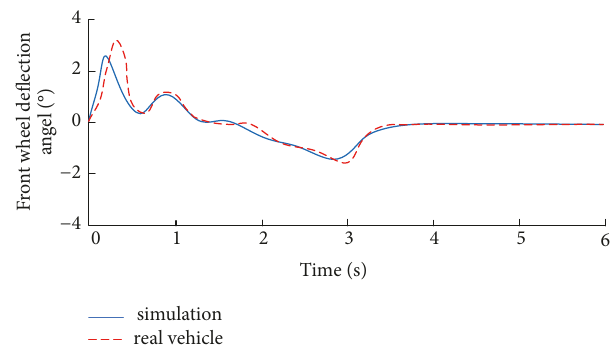
Figure 14: Vehicle front wheel angle diagram.